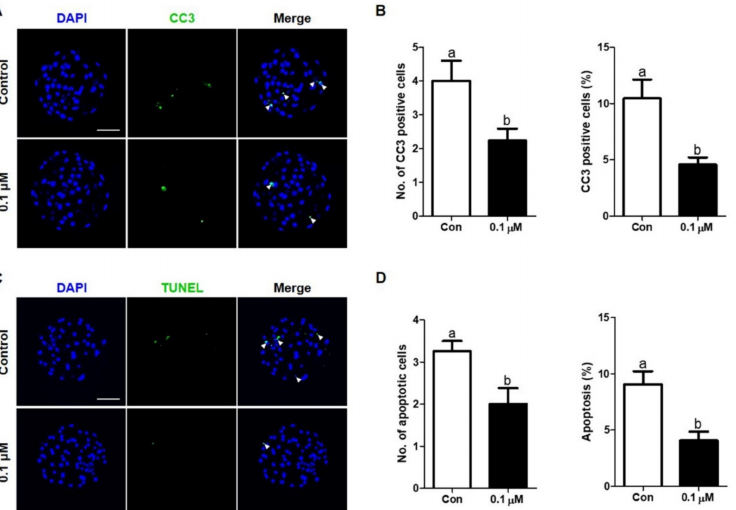
Figure 6. Effect of lycopene on CC3 expression and apoptosis levels in porcine IVF blastocysts. ( A ) Representative images of Day-6 IVF blastocysts of the indicated groups stained with an antibody directed against cleaved caspase 3 and ( B ) comparison of number and percentage of CC3-positive cells in the indicated groups. ( C ) Representative images of TUNEL staining of Day-6 IVF blastocysts treated with or without 0.1 µ M lycopene and ( D ) comparison of number and percentage of TUNEL- positive cells in the indicated groups. Different superscript letters (a,b) represent the significant difference ( p < 0.05). Bar = 100 µ M. Abbreviations: CC3, cleaved caspase 3; IVF, in vitro fertilized; TUNEL, terminal deoxynucleotidyl transferase-mediated dUTP-digoxigenin nick end-labeling; Con, control; 0.1 µ M, 0.1 µ M